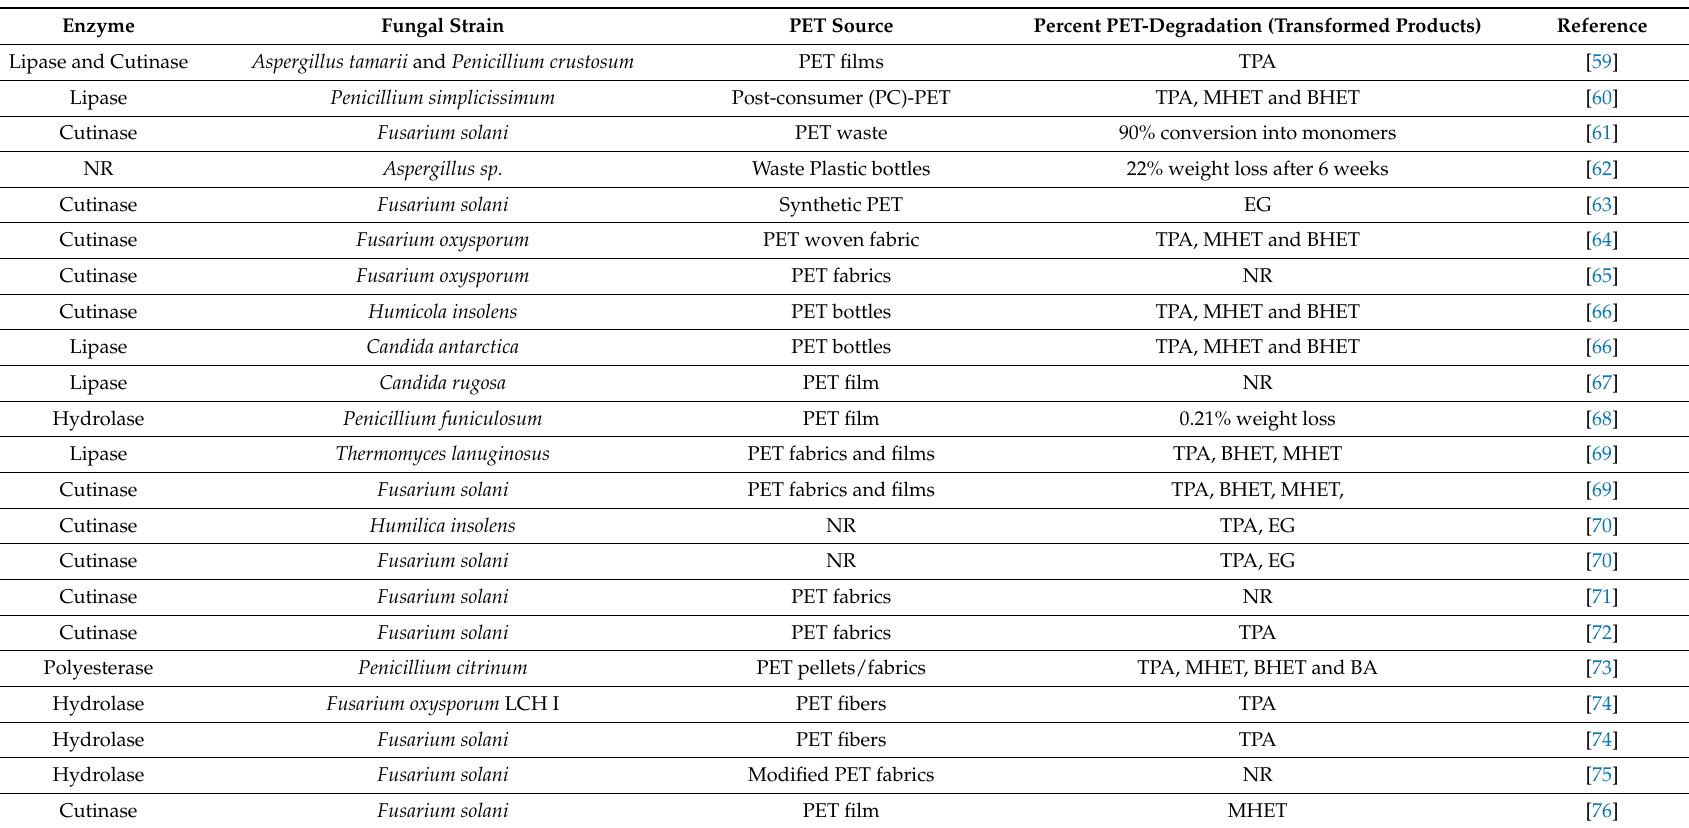
Table 3. Fungal enzyme-mediated polyethylene terephthalate (PET)